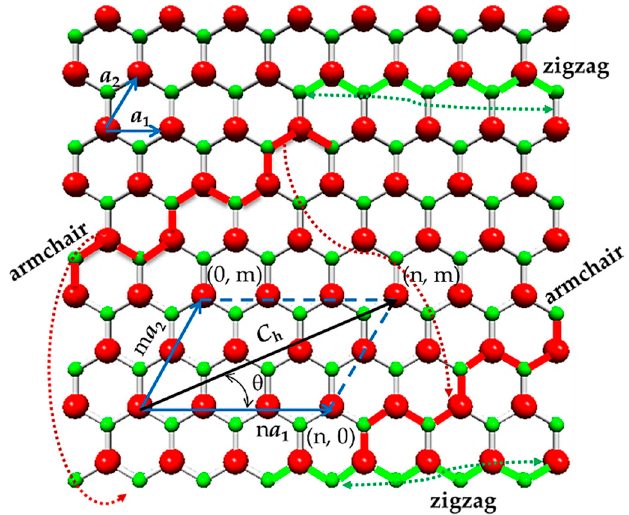
Figure 1. SiC hexagonal sheet with definitions of the chiral indices, n and m, chiral vector, C h , and chiral angle, θ ; scheme for rolling up zigzag and armchair NTs configurations is illustrated. The Si atoms are shown in red; the C atoms in green.